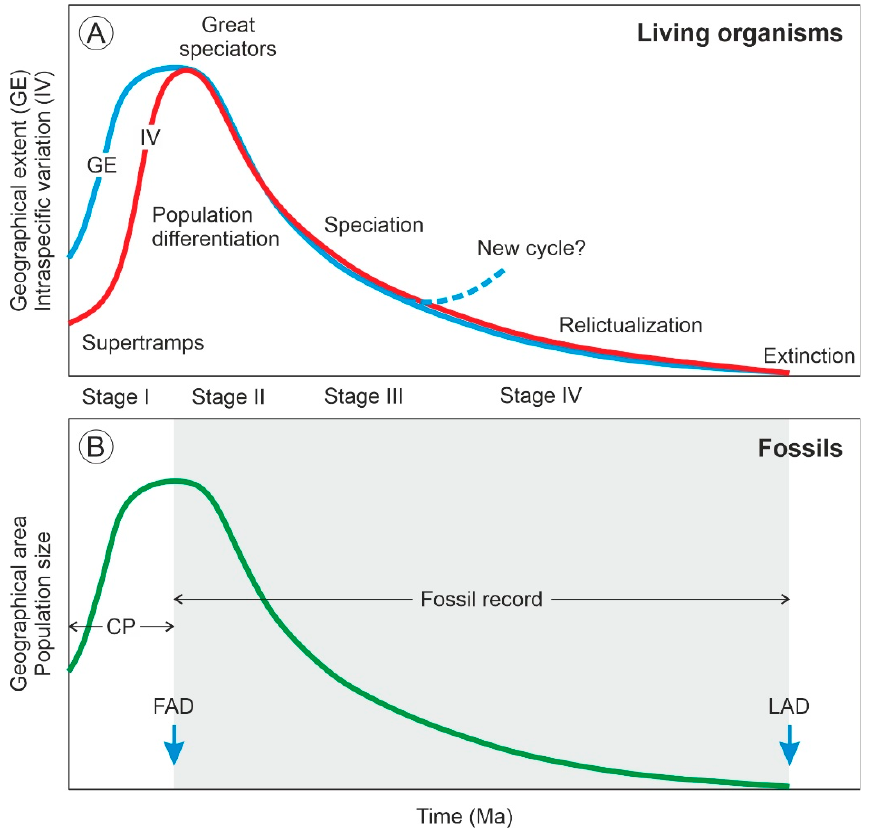
Figure 1. The taxon cycle and its fossil expression. ( A ) Variations in geographical extent and intraspecific differentiation along the stages of the taxon cycle (redrawn from Ref. [5]). ( B ) Variations in the geographical area of fossils according to the asymmetric model [7]. The stages represented in the fossil record (gray area) and the condensed phase (CP), which is apparently unrecorded, are indicated. FAD, first appearance datum; LAD, last appearance datum.